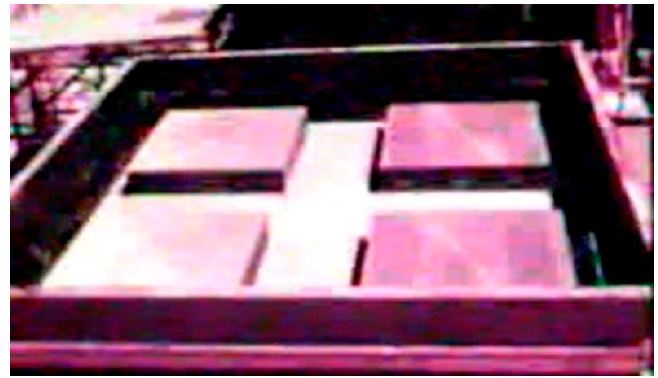
Figure 11. Installed prefabricated unit with four bearings on top of the pedestal [6].